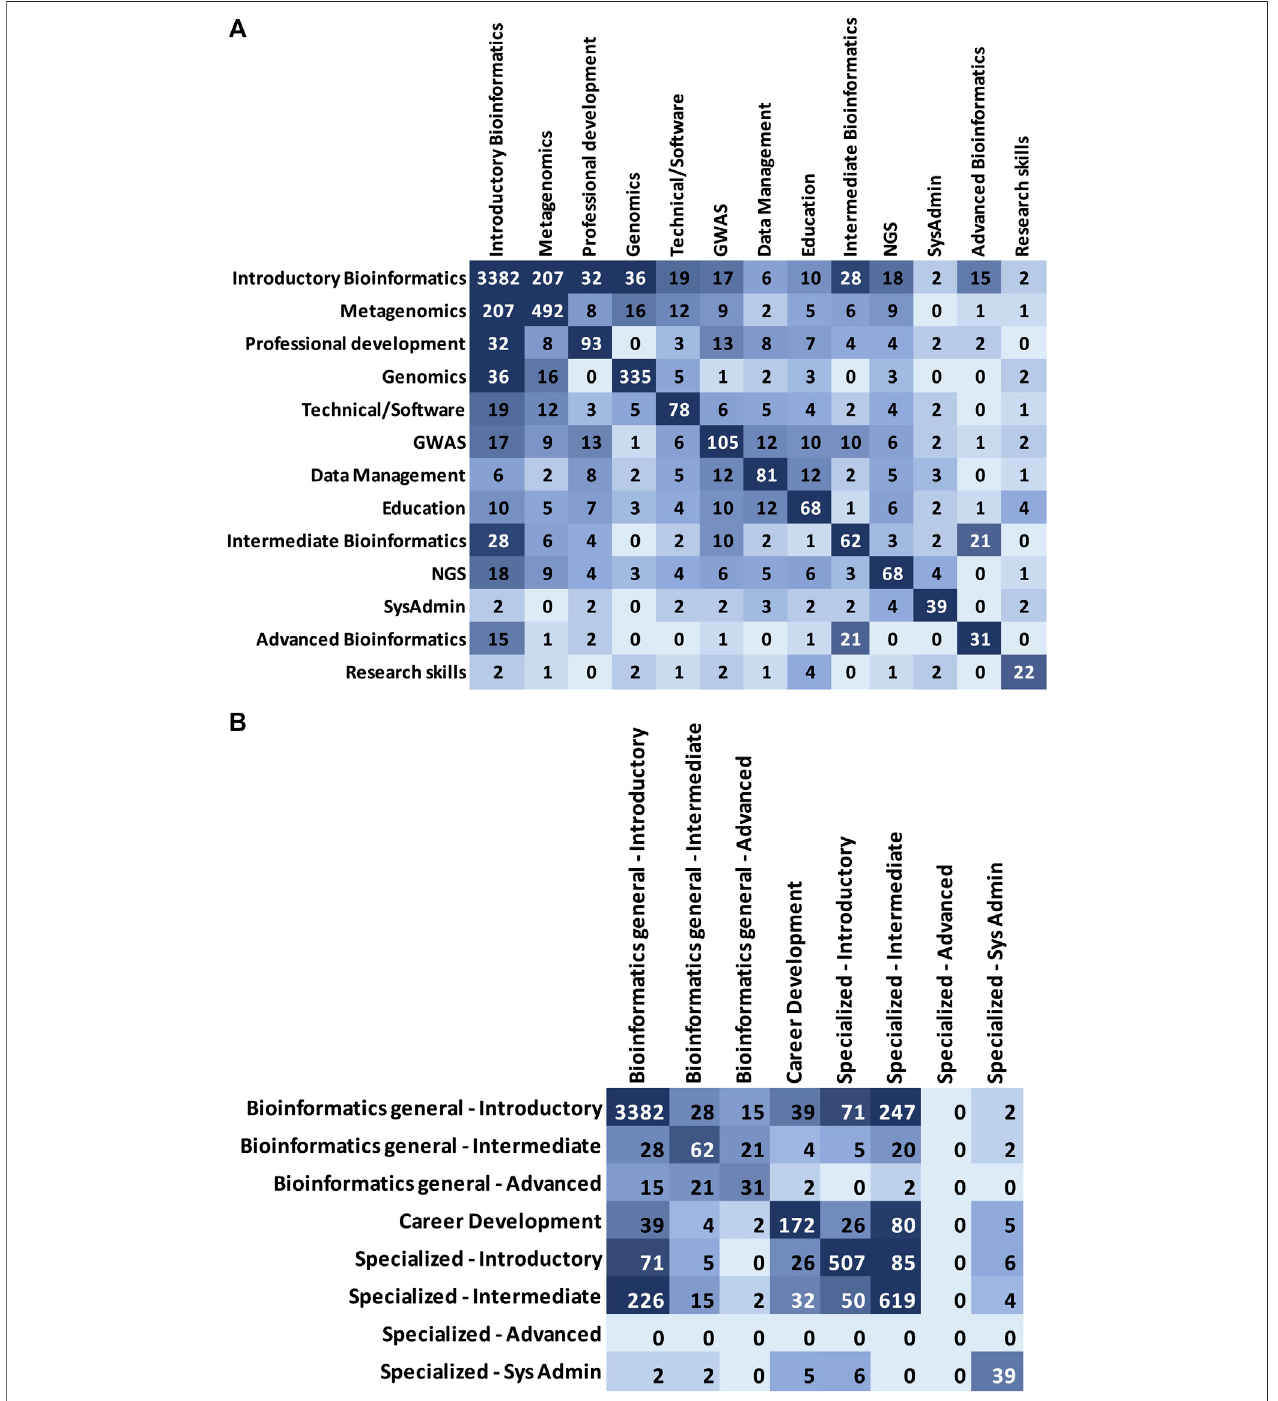
FIGURE 7 | Heatmaps showing the total number of trainees who attended combinations of training events (i.e. more than 1 training), the darker blues represent higher fi guresandthereforethemostpopulartrainingcombinations. (A) Showswhichothertrainingtopicswerecommonlyattendedbythesametrainee. (B) Alsoshows which other trainings were commonly attended by the same trainee but grouped by training category. Refer to Supplementary Table S1 for further details on the training events under each training category and topic.